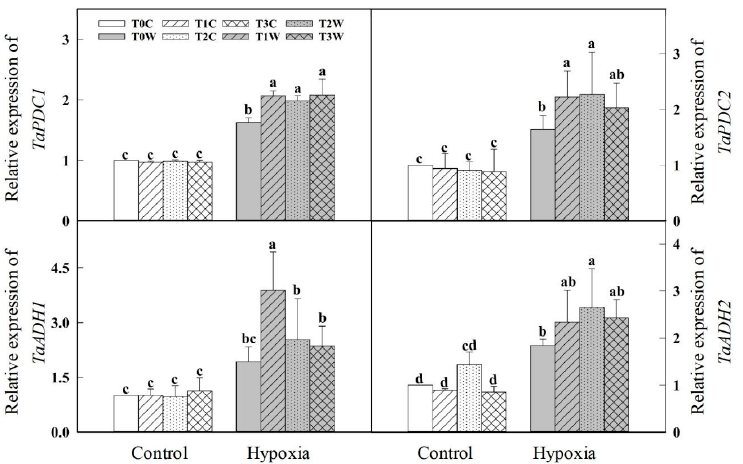
Figure 6. Effects of waterlogging priming on TaPDC , TaADH gene expression in root of offspring plants under hypoxia stress in wheat seedling. Note: TaPDC1 , TaPDC2 : pyruvate decarboxylase gene; TaADH1 , TaADH2 : alcohol dehydrogenase gene. T0C, no priming + no offspring hypoxia stress; T0W, no priming + offspring hypoxia stress; T1C, one-generation priming + no offspring hypoxia stress; T1W, one-generation priming + offspring hypoxia stress; T2C, two-generation priming + no offspring hypoxia stress; T2W, two-generation priming + offspring hypoxia stress; T3C, three-generation priming + no offspring hypoxia stress; T3W, three-generation priming + offspring hypoxia stress. Data are means ± SE (n = 3). Different lowercase letters indicate the significant difference at p < 0.05 level.